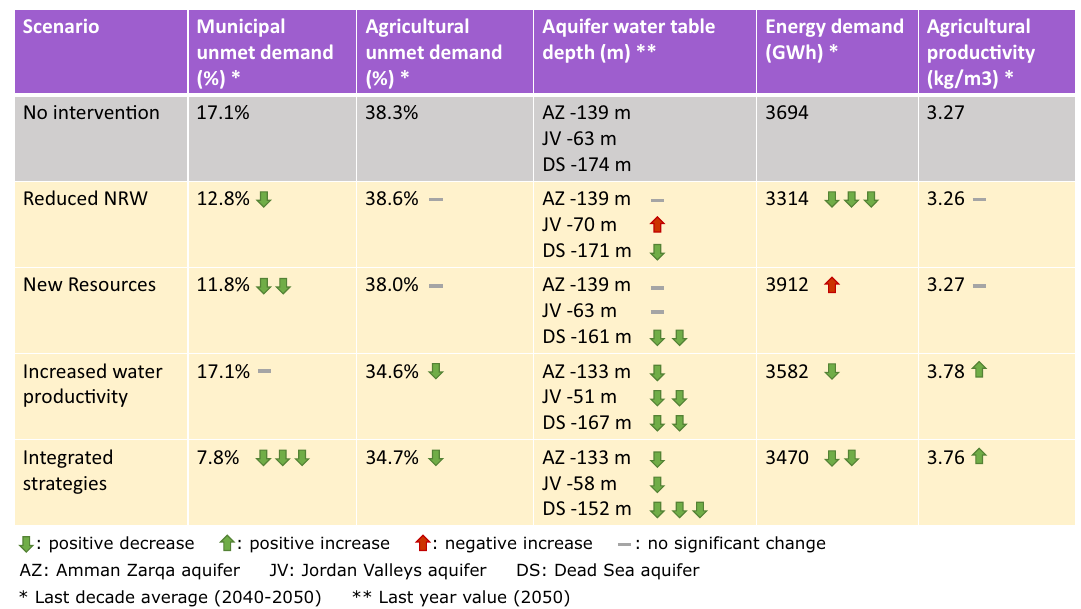
Table 1 Scenario analysis summary of